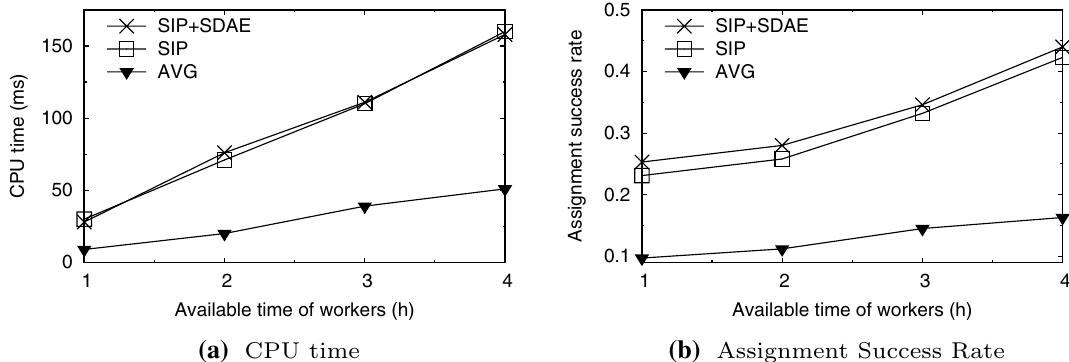
Fig. 4 Performance of preference modeling: effect of